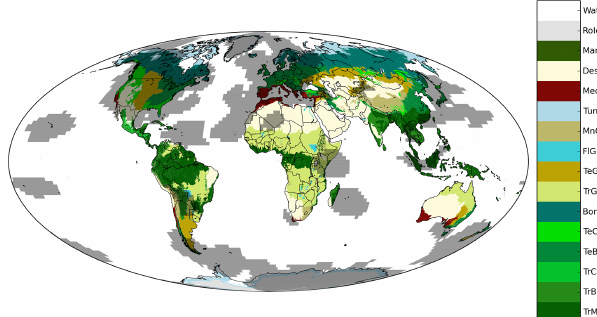
Figure 3. Map of terrestrial biomes (Olson and Dinerstein, 2002; The Nature Conservancy, 2012) shaded by ozone observational cov- erage. Dark regions of the biomes are areas that are covered by the footprints of ozone sites; light regions do not have ozone observa- tions. Biome abbreviations refer to the following: Wat (water), RoIc (rock and ice), Mang (mangroves), Des (deserts and xeric shrub- lands), Med (Mediterranean forests, woodlands, and scrubs), Tund (tundra), MnG (montane grasslands and shrublands), FlG (flooded grasslands and savannas), TeG (temperate grasslands, savannas, and shrublands), TrG (tropical and subtropical grasslands, savannas, and shrublands), BorF (boreal forests/taiga), TeCF (temperate conifer forests), TeBF (temperate broadleaf and mixed forests), TrCF (trop- ical and subtropical coniferous forests), TrBF (tropical and subtrop- ical dry broadleaf forests), and TrMF (tropical and subtropical moist broadleaf